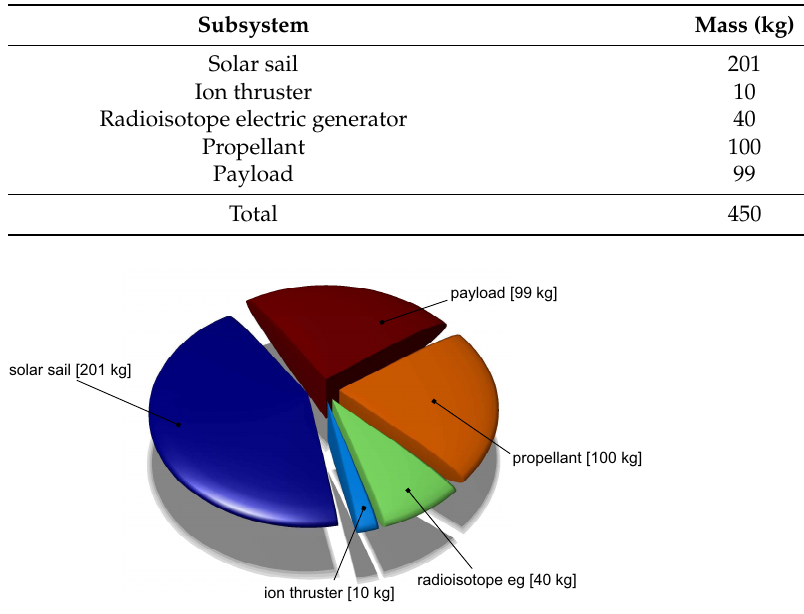
Table 1. Hesperides spacecraft subsystems mass [18].